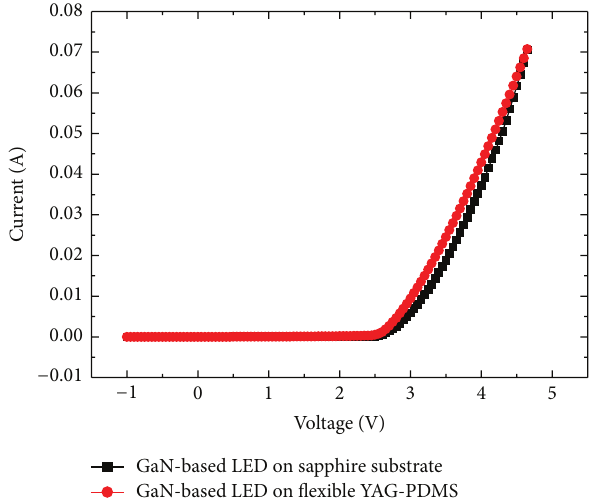
Figure 3: Transmittance spectra of YAG-PDMS substrates with various YAG incorporation